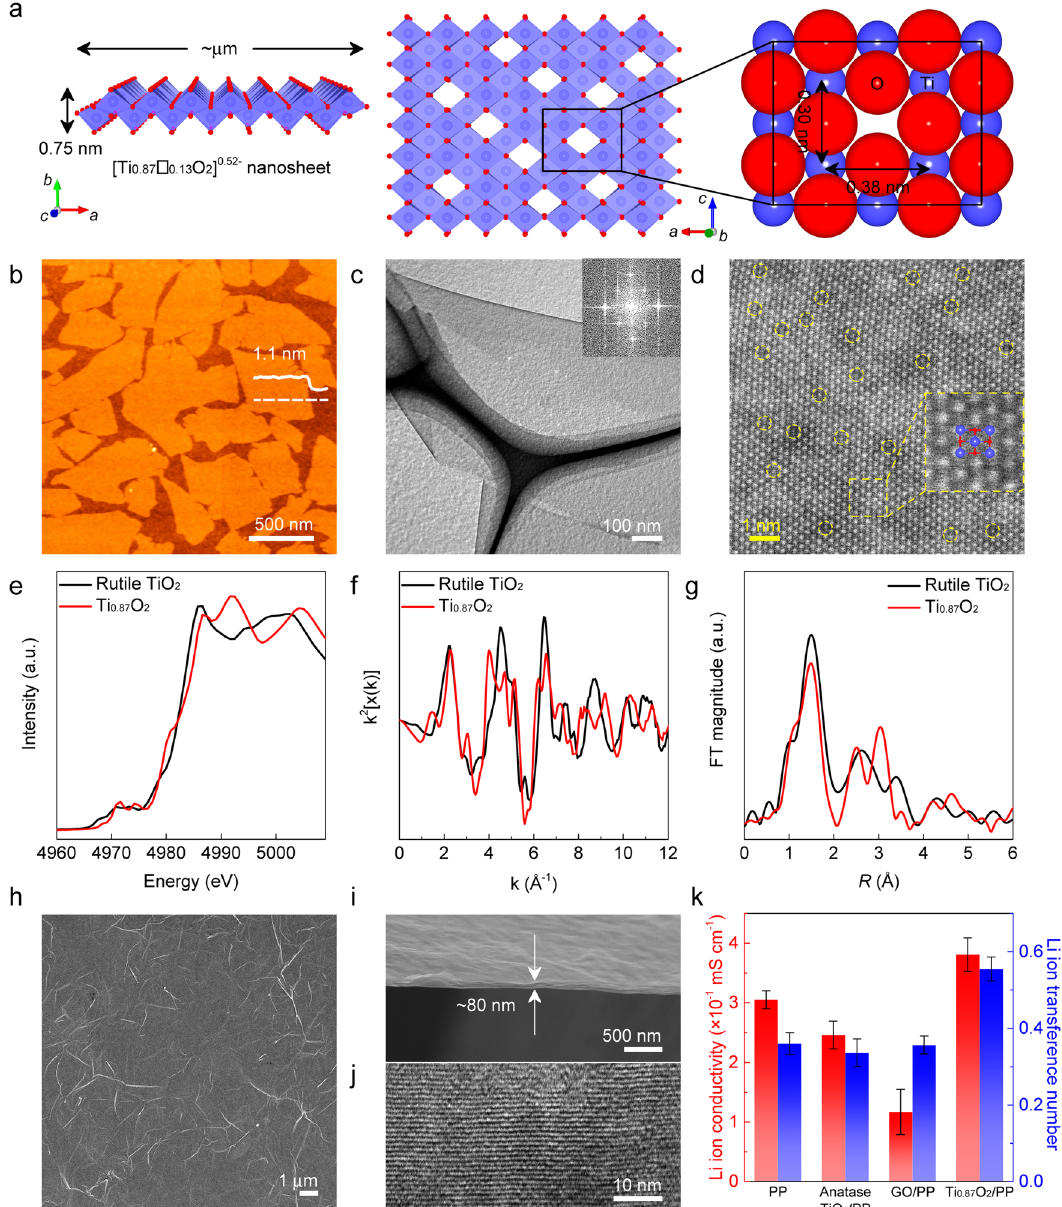
Fig. 2 Fabrication and characterization of Ti 0.87 O 2 nanosheets and Ti 0.87 O 2 /PP separators. a Crystal structures of Ti 0.87 O 2 nanosheet with respect to c - and b -axes. Enlarged structure using ionic radii to show the relative size of the Ti vacancy. b AFM image of Ti 0.87 O 2 nanosheets. The nanosheets were deposited onto Si wafer substrates. c TEM image and SAED pattern of a Ti 0.87 O 2 nanosheet. d HAADF-STEM image of a Ti 0.87 O 2 nanosheet. e X-ray absorption near edge structure (XANES) of Ti K edge for commercial rutile TiO 2 and a freeze-dried sample of Ti 0.87 O 2 nanosheets. f The k 3 -weighted EXAFS in K -space for commercial rutile TiO 2 and a freeze-dried sample of Ti 0.87 O 2 nanosheets. g Fourier transforms of k -space oscillations of Ti K edge of commercial rutile TiO 2 and a freeze-dried sample of Ti 0.87 O 2 nanosheets. h SEM image showing a top-down view of a Ti 0.87 O 2 /PP separator. i SEM image showing a side-on view of a Ti 0.87 O 2 /PP separator. j TEM image showing a side view of a Ti 0.87 O 2 /PP separator. k Li-ion conductivity and Li-ion transference number of PP, anatase TiO 2 /PP, GO/PP, and Ti 0.87 O 2 /PP separators. Error bars were included, which represent the standard deviation of the data taken from fi ve